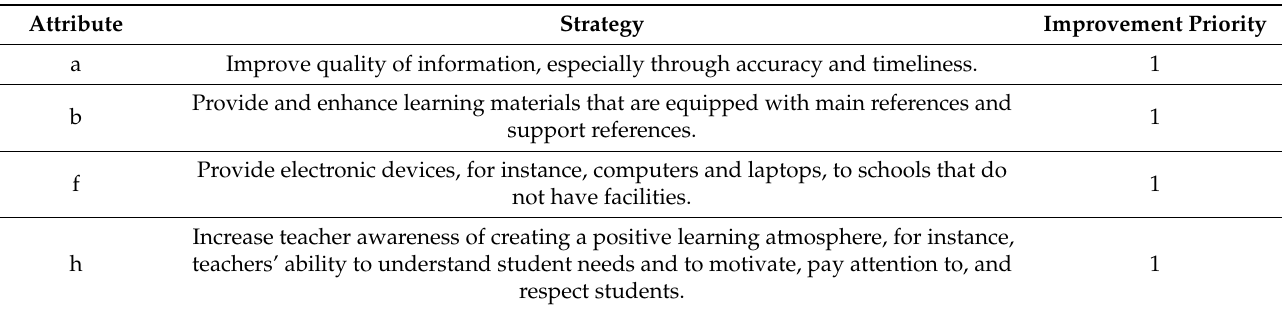
Table 6. Prioritized Recommendations for E-learning Improvement Strategies.